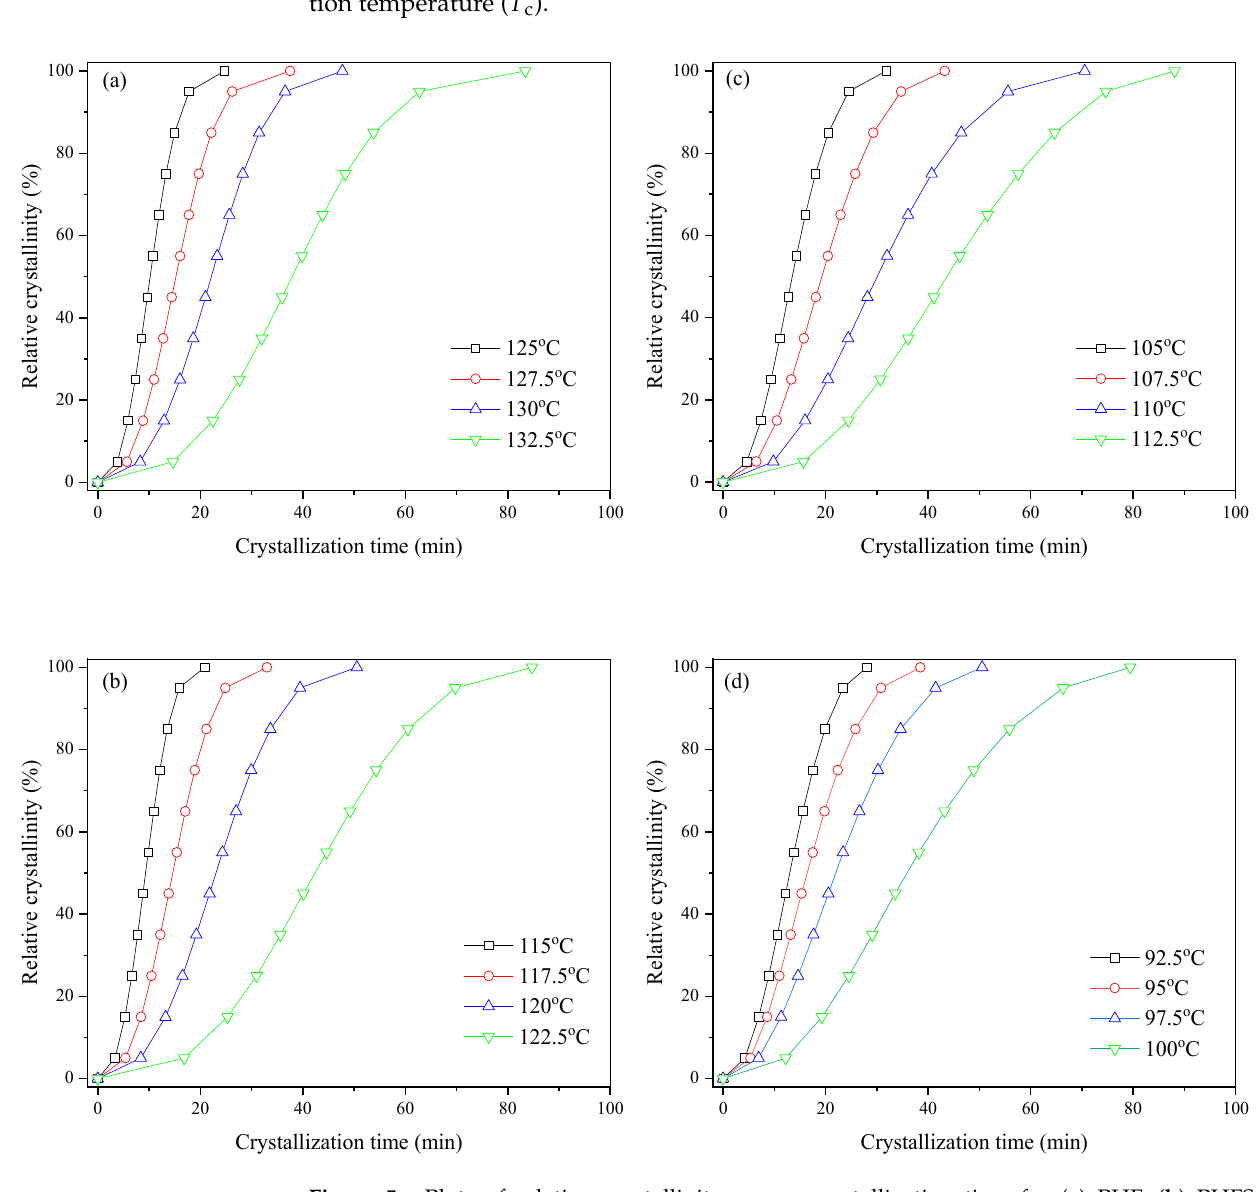
Figure 5. Plots of relative crystallinity versus crystallization time for ( a ) PHF, ( b ) PHFSe10, ( c ) PHFSe20, and ( d ) PHFSe30.